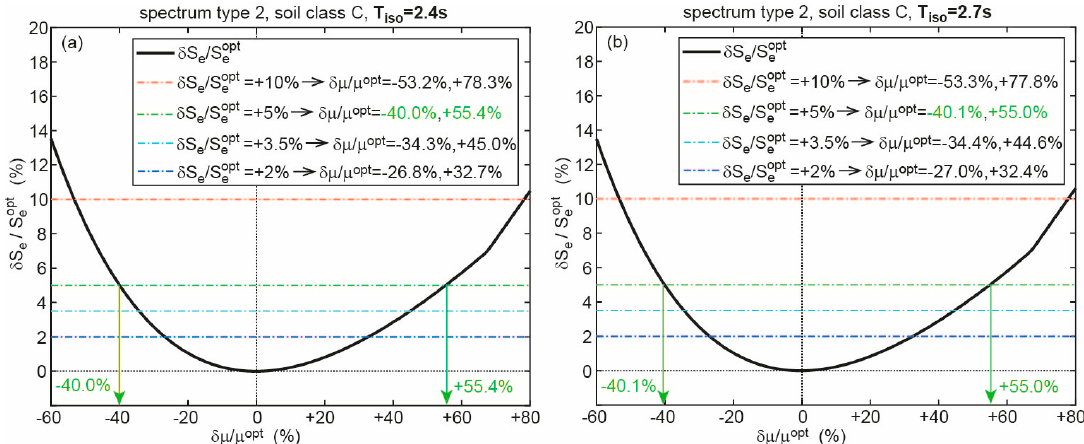
Figure 19. Sensitivity of deviation in friction coefficient from its optimum value on relative increase of structural acceleration for ( a ) T iso = 1.8 s and ( b ) T iso = 2.1 s and spectrum of type 2 with soil class C.